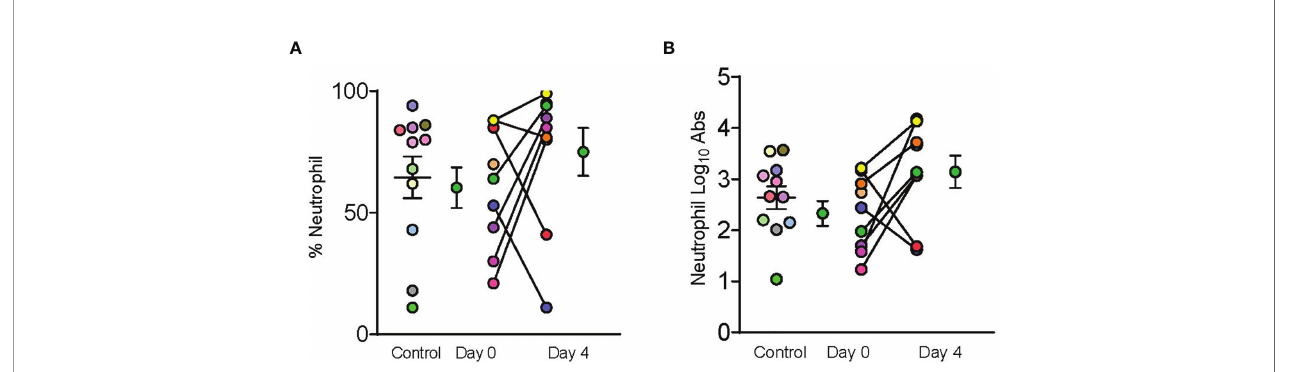
FIGURE 3 | Dornase alfa treatment did not reduce BALF neutrophils. Control, day 0 and day 4 symbols are displayed as mean ± SEM of 11 subjects in the control group and 9 subjects in the treatment group. Each individual color-coded point with connecting line between day 0 and 4 represents a unique patient in the treatment group (N=9). Two patients only had samples from a single time point due to sample degradation. Only 11 subjects in the control group underwent BALF sampling during hospitalization and are represented by individual colored coded data points. No statistically signi fi cant difference was noted in (A) % Neutrophils, or (B) log transformed absolute neutrophil counts in the bronchoalveolar fl uid between case control patients and patients prior to receiving dornase alfa.